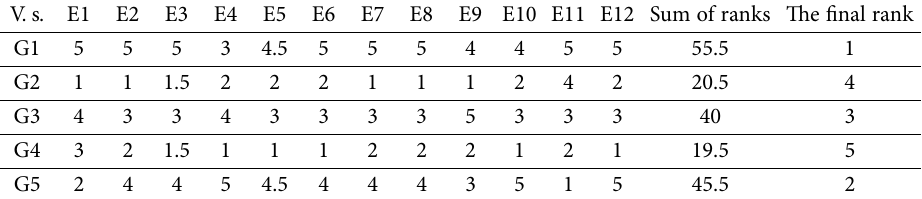
Table 8. Ranking factors in the group of a legal environment (for unprotected technology) regarding the commercial potential of technologies